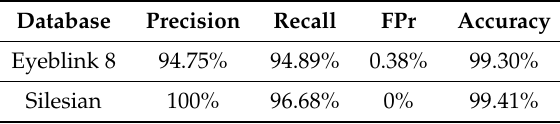
Table 2. Blink detection algorithm